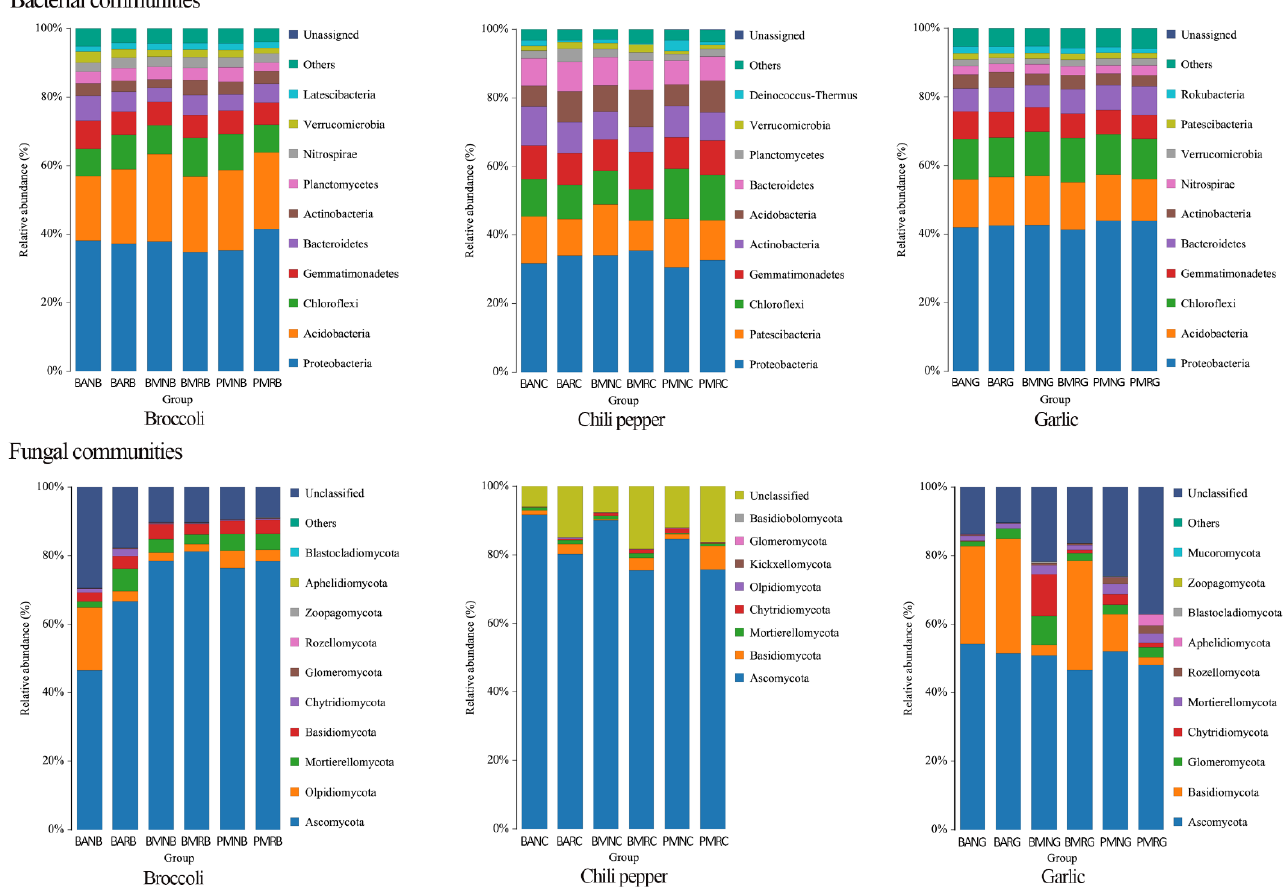
Figure 5. The composition and relative abundance of bacterial and fungal communities at phylum level in three different vegetable fields under different treatments.